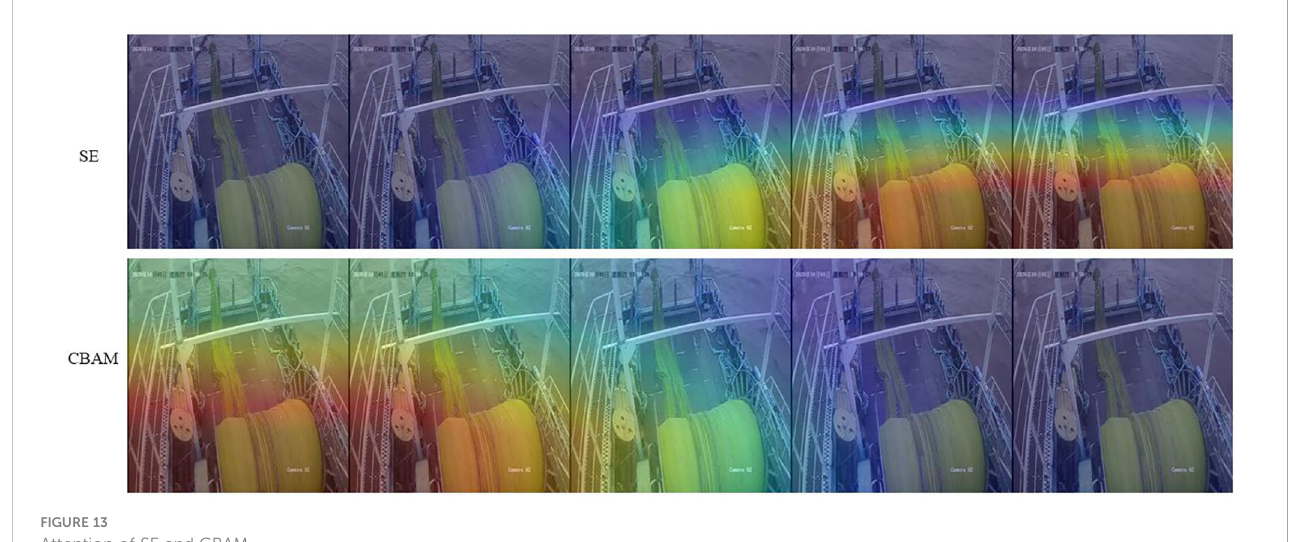
FIGURE 13 Attention of SE and